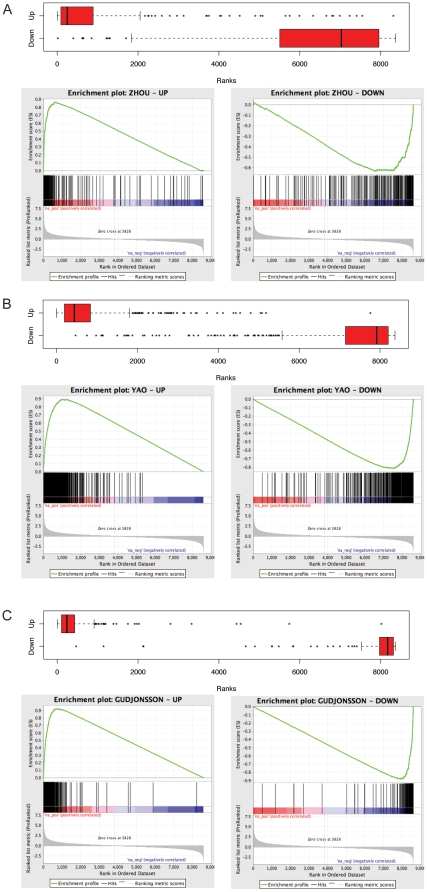
Rank of the published DEG lists in our fold change data.
A. Rank of Zhou's genes in our data set ordered by fold change expression, with Enrichment plots for the up-regulated and downregulated genes data below. B. As A but for Yao's study. C. As A but for Gudjonsson's study. A detailed explanation of Enrichment plots can be found in Figure 1 of original Subramanian et al
[10].